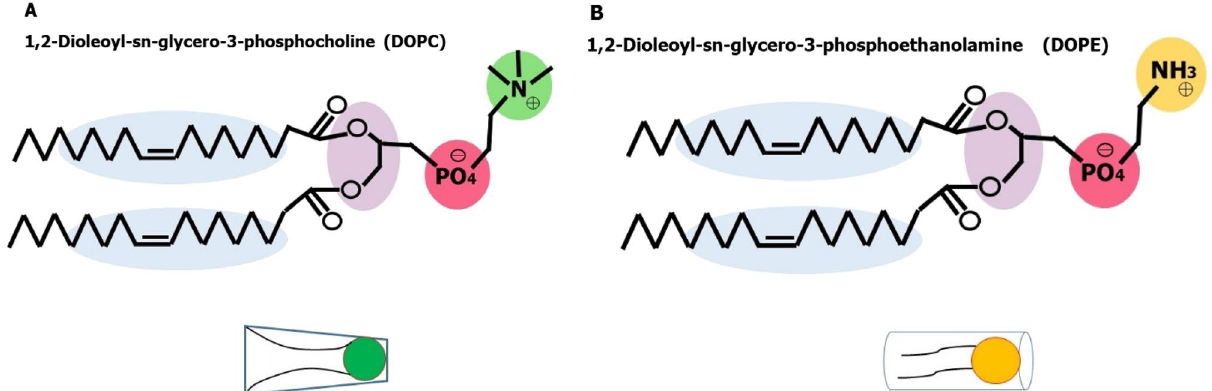
Figure 1. The phospholipids schematic structure used in the system simulation. ( A ) 1,2-Dioleoyl-sn-glycero-3- phosphocholine (DOPC). ( B ) 1,2-Dioleoyl-sn-glycero-3- phosphoethanolamine (DOPE). The glycerol residues are shown in purple, the phosphate groups in red, the fatty acids in blue, the choline group in green, and the amine group in